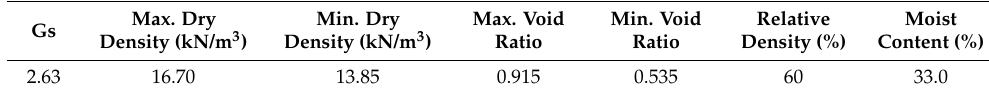
Table 1. Physical properties of Jumunjin sand.